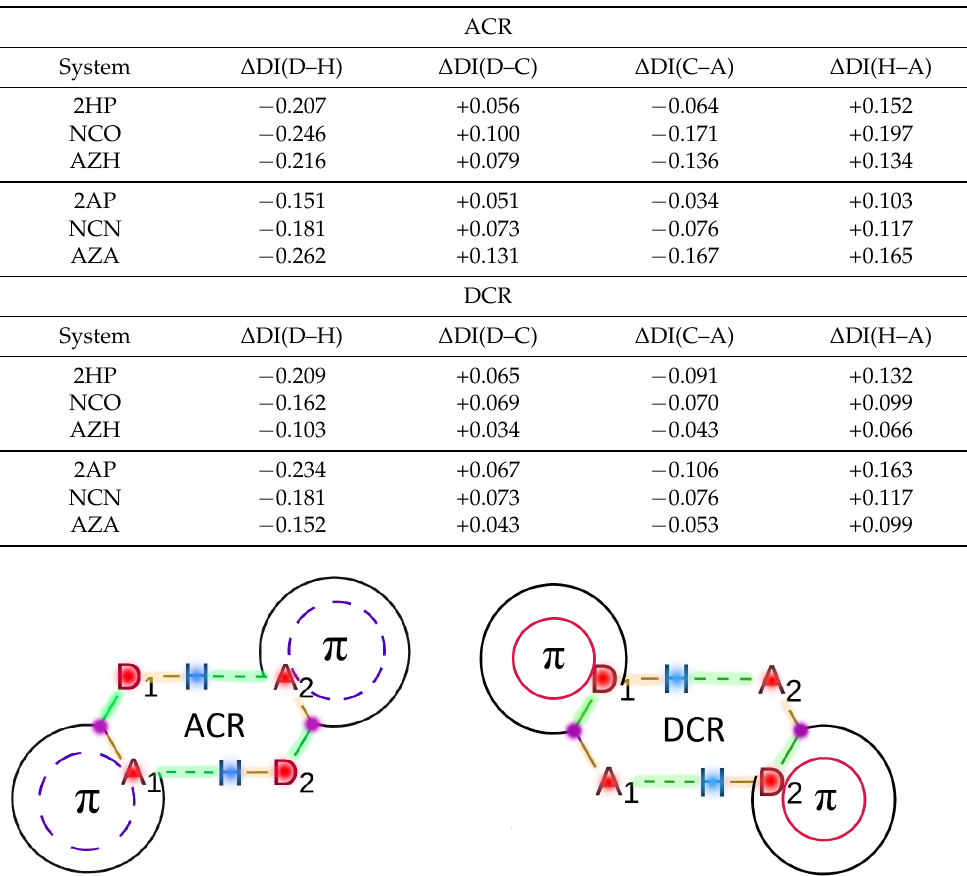
Table 3. Change in the electron delocalisation index of the atoms involved in the HB contacts (Figure 3) upon the formation of the dimers with (i) the hydrogen bond acceptor contained within the ring (ACR) and (ii) the hydrogen bond donor contained within the ring (DCR). These changes are computed with respect to the values of the monomers, which were used as references. Atomic units are used throughout.